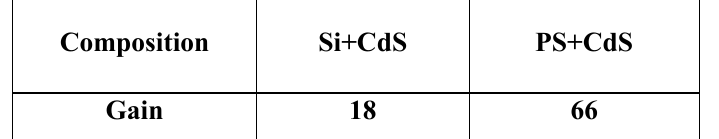
Table 2: The measurement of photoelectric gain for CdS photodetector Composition